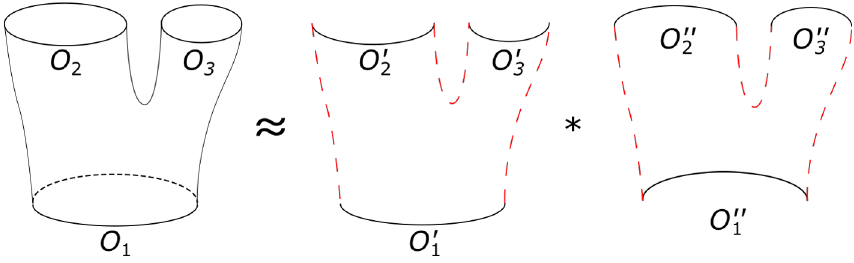
Figure 1 . The main idea of ref. [13] is to “cut open” the three-point function in string theory to get two patches of worldsheet with six distinct edges (hexagon tesellation). This is the analogue of considering the infinite-volume worldsheet theory for the spectral problem (i.e., cutting open a cylinder into a